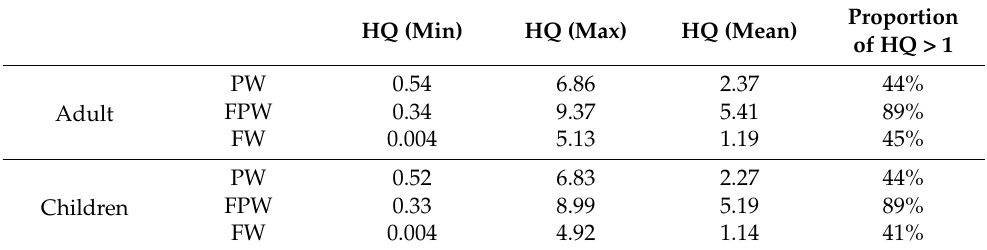
Table 1. Health risk indicators of different groundwater types.